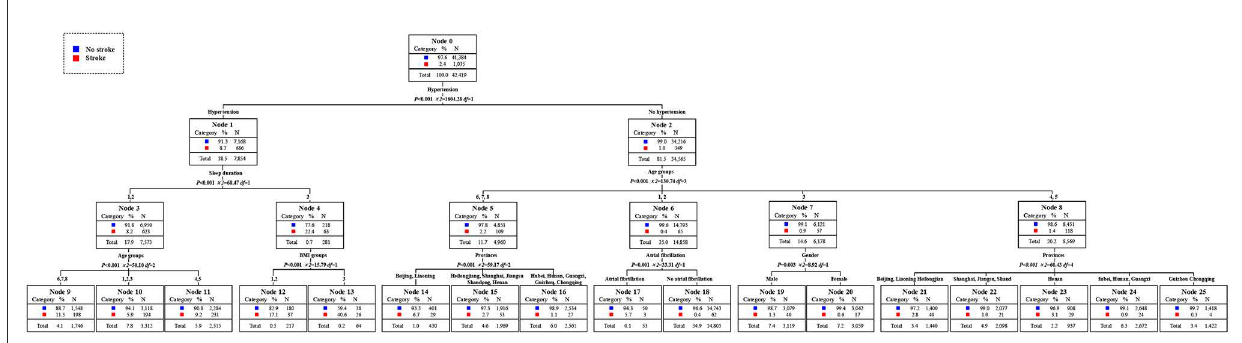
FIGURE3 Assessment of risk factors and the susceptible population of stroke,